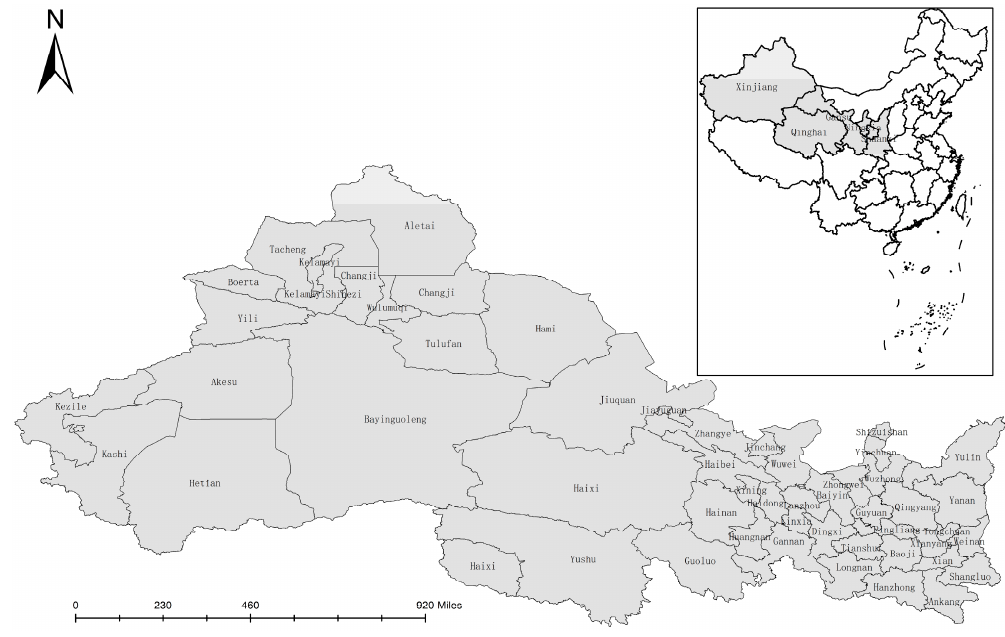
Figure 1. Study area in northwest China.